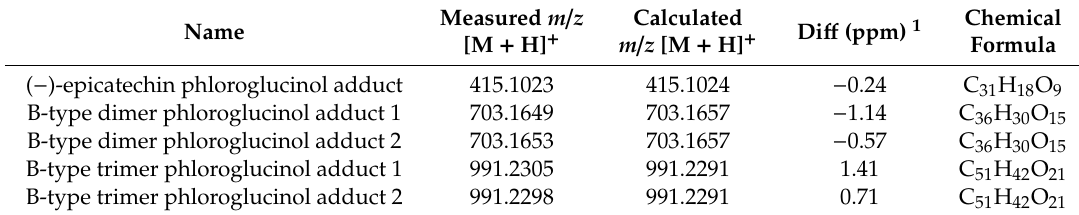
Table 1. Released product after chemical depolymerization of 1 detected by